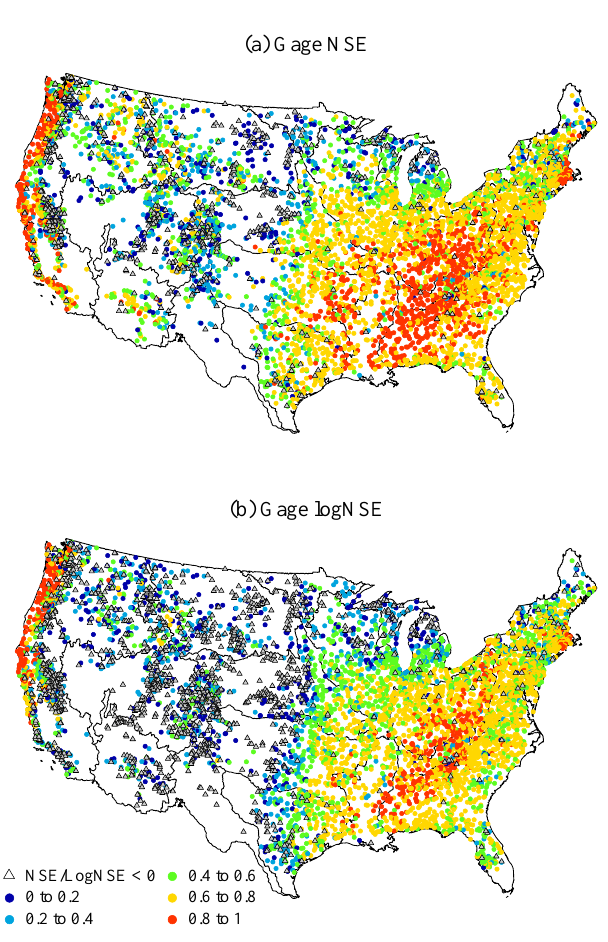
Figure 9. Individual streamgage calibration results: (a) Nash– Sutcliffe efficiency (NSE) coefficient and (b) log of the NSE